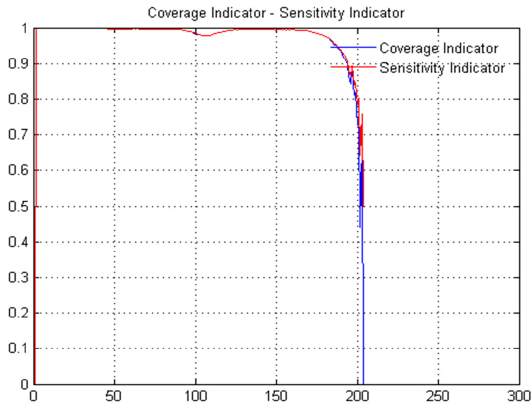
local minima. The local minima located at the ends of the range of values are not useful and are ignored. The local minimum located close to 105 provides the best threshold